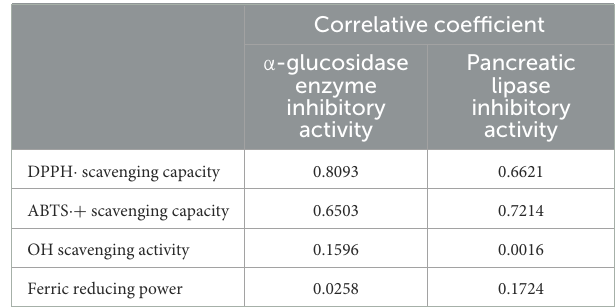
TABLE 6 A correlation between biochemical composition and antioxidant